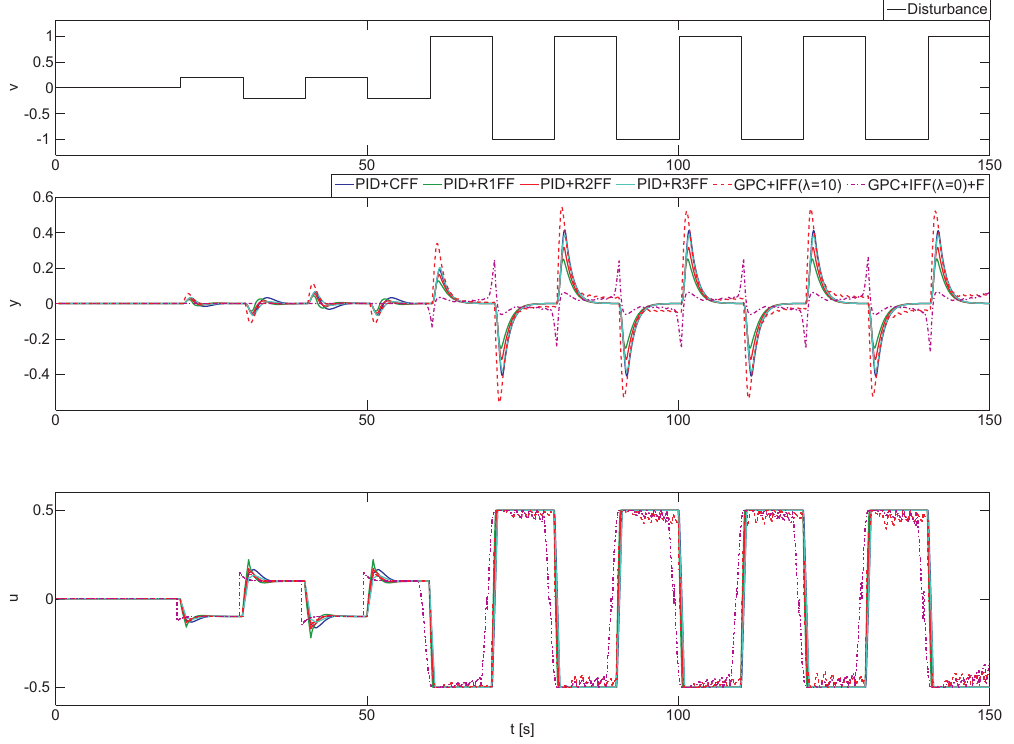
Figure 5. Control results for non-realizable feedforward compensator with constraints on the control